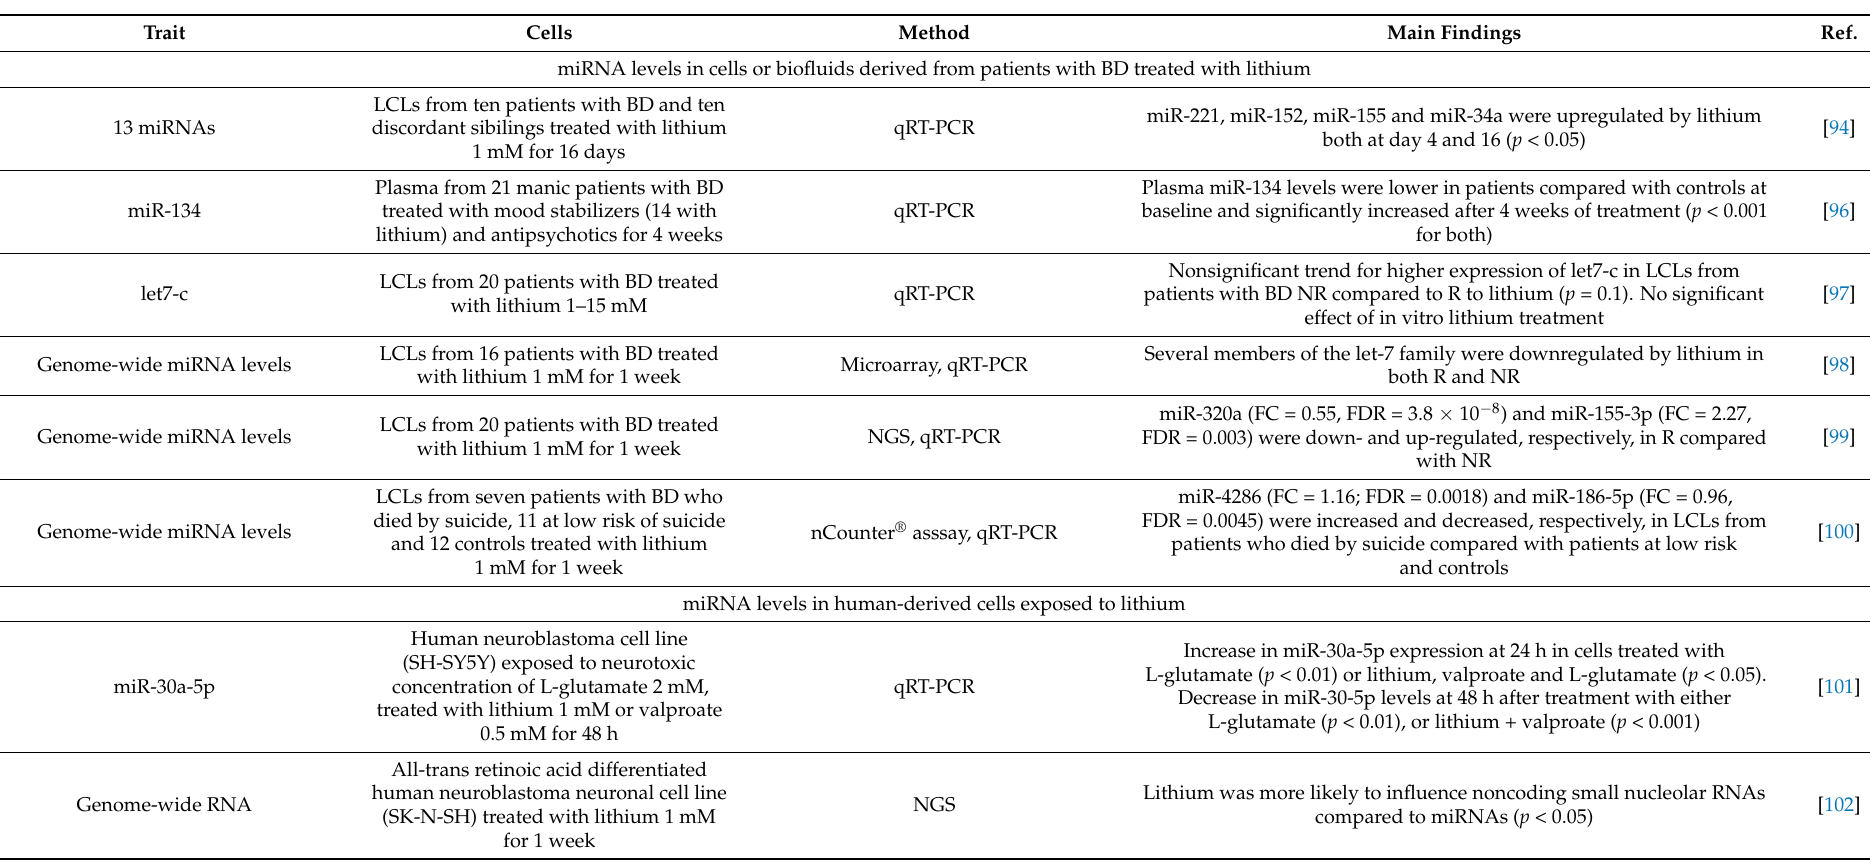
Table 4. Studies investigating noncoding RNAs in cells or biofluids derived from patients with BD treated with lithium or other human-derived cell lines exposed to